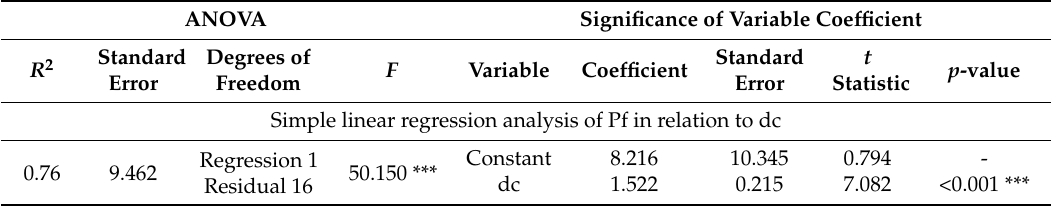
Table 9. Linear regression analysis of the chainsaw productivity in relation to the cross-section diameter. ANOVA Significance of Variable Coefficient R